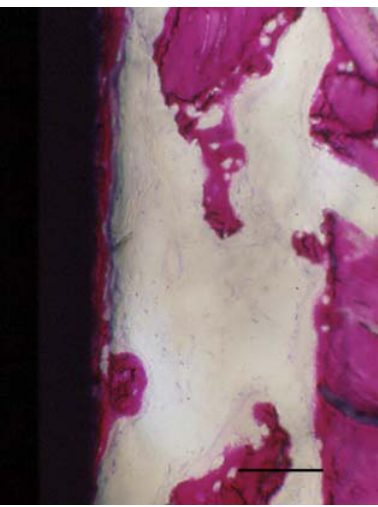
FIGURE 3 . LM image of Zr-SLA screw 2 weeks after surgery. Newly formed bone trabeculae develop both from host bone (on the right) and directly on the metal surface. Many osteoblasts